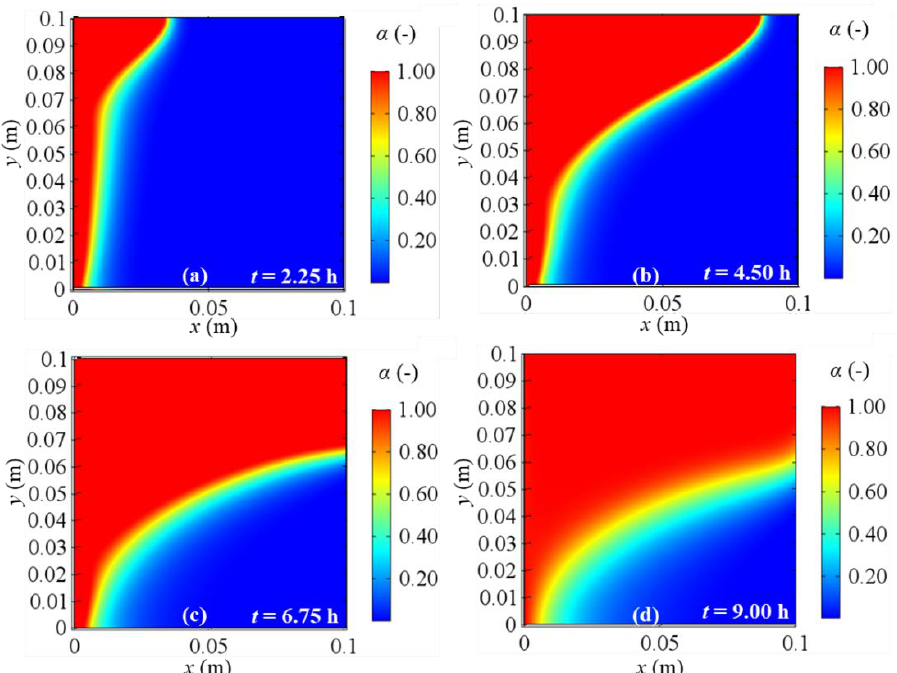
Figure 15. Melting fraction evolution for 2D model with natural convection and BC 2 at different evaluation times: ( a ) after 2.25 h; ( b ) after 4.50 h; ( c ) after 6.75 h; ( d ) after 9.00 h from the simulation beginning respectively.